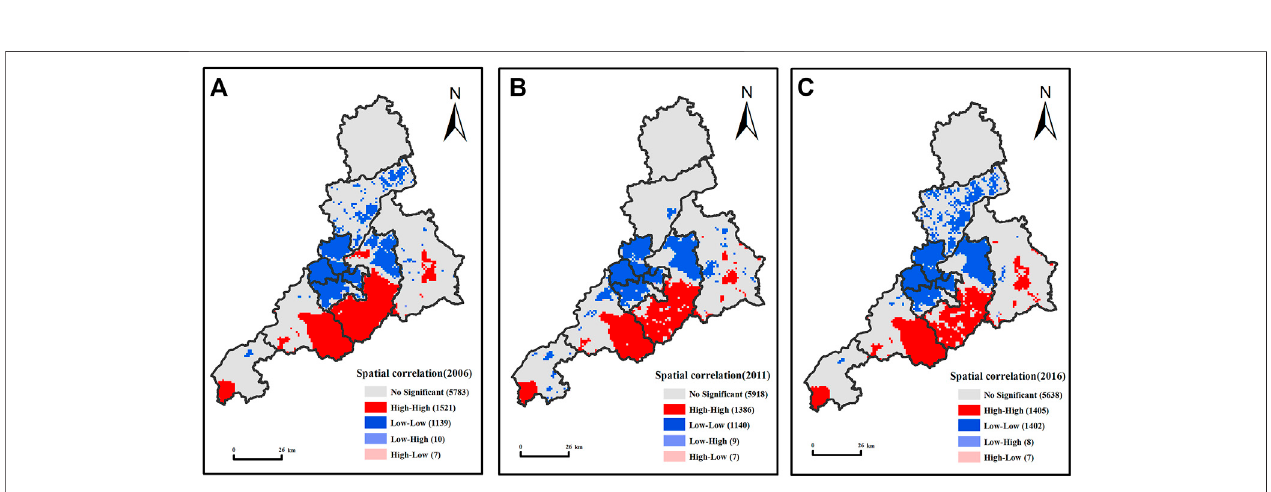
FIGURE 6 | Spatial correlation of land ecological security condition in different years. (A – C) represent the results in 2006, 2011 and 2016.